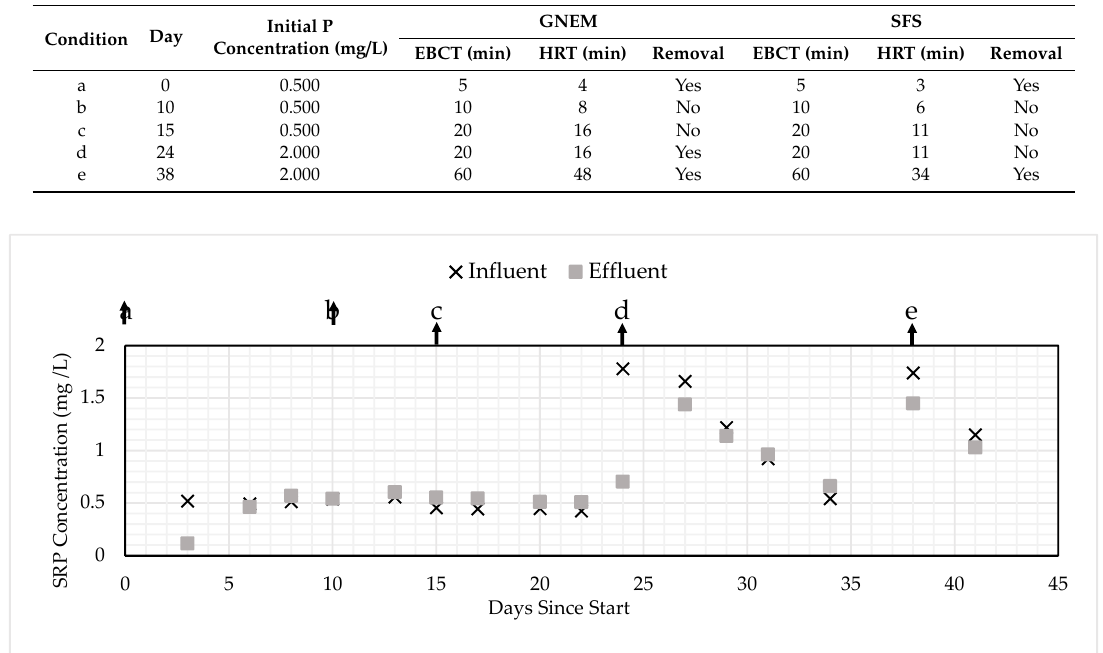
Figure 6. SRP removal for the GNEM under changing initial concentrations and empty bed contact times/hydraulic retention times (EBCTs/HRTs). Int. J. Environ. Res. Public Health 2020 , 17 , x